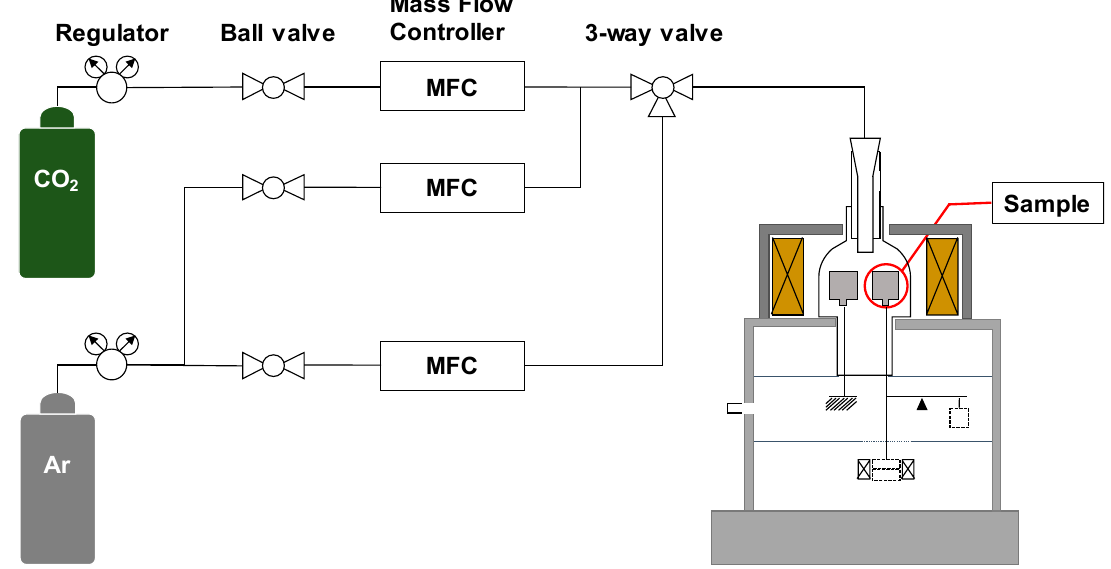
Figure 2. Schematic diagram of a TGA system (TGD-9600, Advance RIKO, Inc., Kanagawa, Japan).